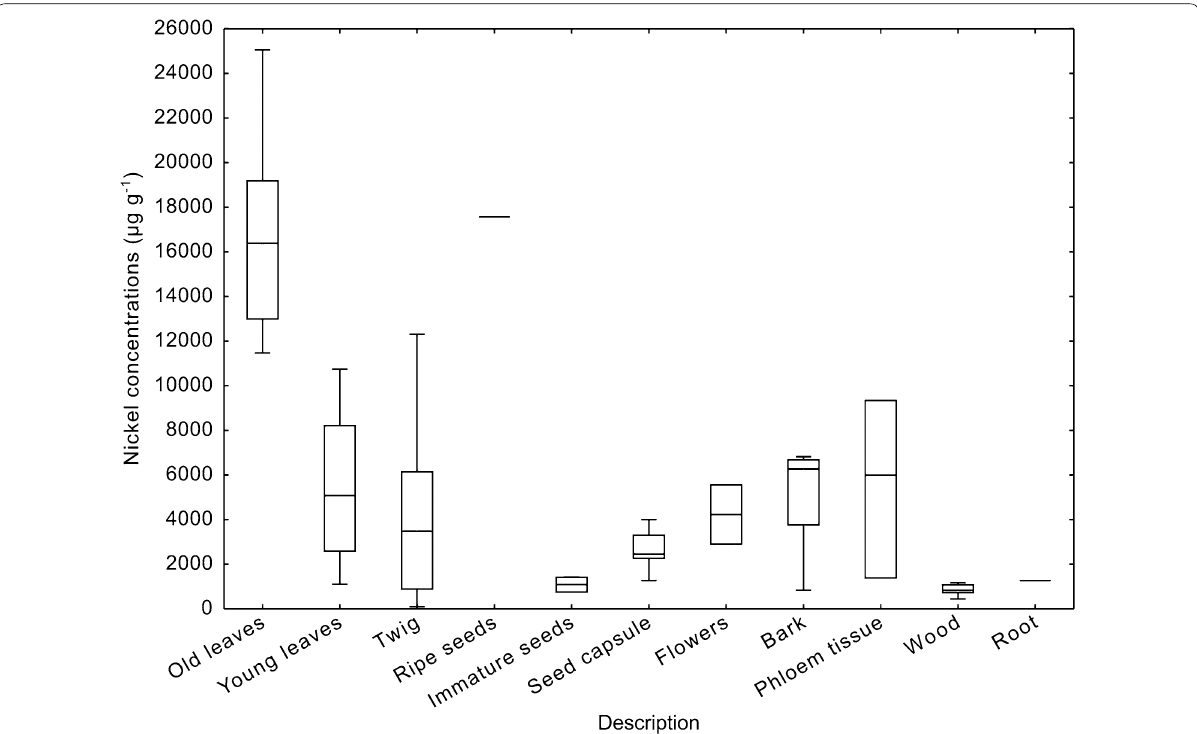
Fig. 4 Elemental concentration in various plant parts of P. rufuschaneyi . Data from Tables 1 and